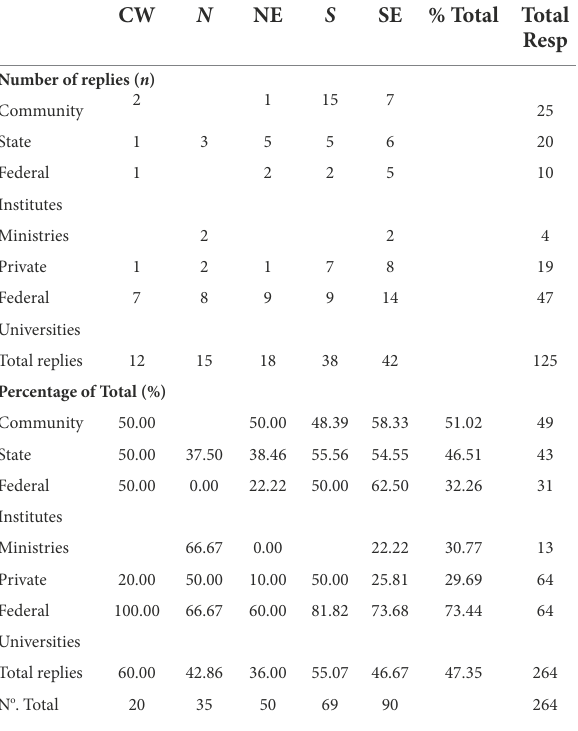
TABLE 1 Number and percentages of responding institutions by type and region. CW N